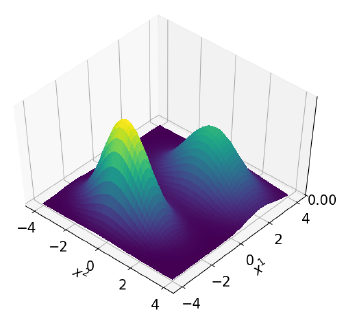
Figure 8. A non-Gaussian pdf that is conditionally Gaussian. More specifically, when knowing x 1 , x 2 can be approximated by a Gaussian pdf. Notice x 1 can be a bi-modal, non-Gaussian distribution if x 2 is given, e.g., for x 2 =